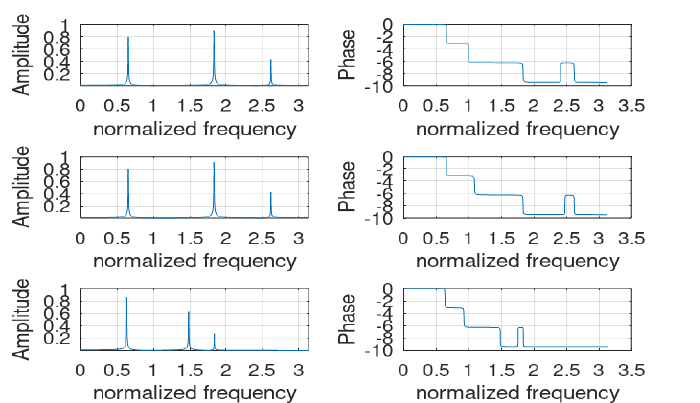
Figure 4. Comparison of original (upper) and transformed frequency responses with θ = e pT , + pT ζ = 2 , and T = 0.0262. 2 − pT